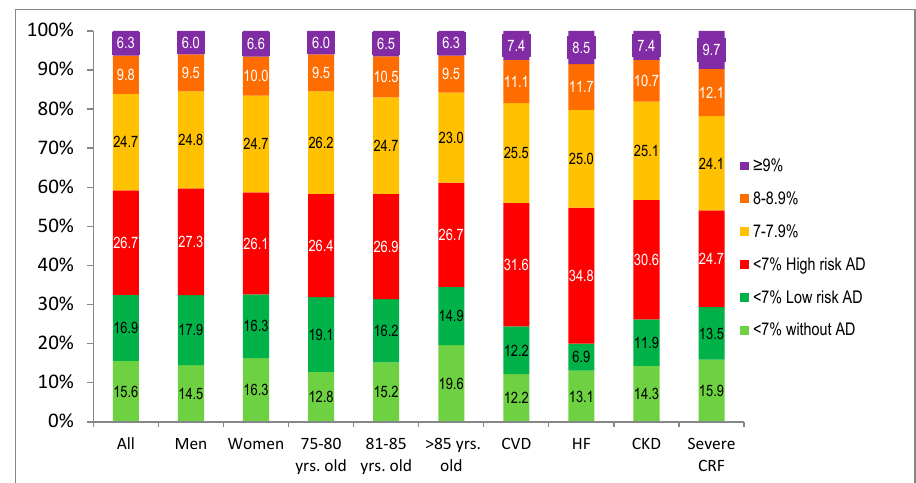
Figure 1. Degree of glycemic control. ( a ) Degree of glycemic control (HbA1c categories) by sex, age subgroups, and comorbidities; ( b ) Degree of glycemic control (HbA1c categories) by sex, age subgroups, and comorbidities considering the use of antidiabetic drugs in patients with HbA1c < 7%.